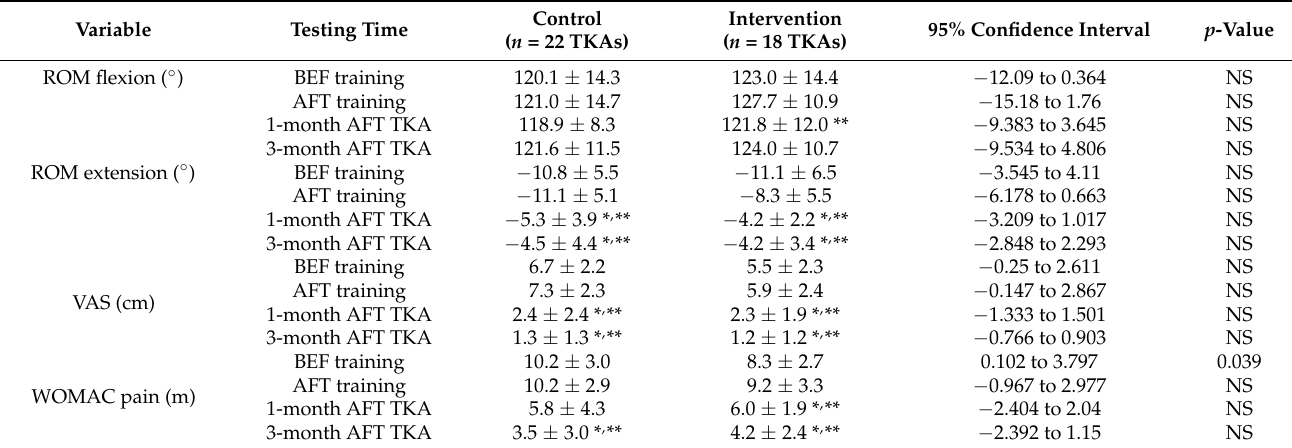
Figure 3. Comparison of quadriceps muscle strength between the intervention and control groups. Data are presented as mean ± standard deviation. *, p < 0.05, compared with BEF training; ‡, p < 0.05, compared with AFT training; ¶, p < 0.05, compared with 1M AFT TKA; #, p < 0.05, compared with the control group. BEF, baseline 3 weeks before surgery; AFT, after 3 weeks of preoperative training; M, month; TKA, total knee arthroplasty. Data are presented as mean ± standard deviation. The range of motion for knee extension significantly improved in both groups at 1 and 3 months after total knee arthroplasty compared to their performance at baseline and after 3 weeks of preoperative training. The range of motion for knee flexion significantly decreased in the intervention group 1 month after total knee arthroplasty compared to their performance after 3 weeks of preoperative training. The control group did not differ significantly at each time period. There were no significant differences in the range of mo ‐ tion for knee flexion or extension between the groups (Table 2). VAS score (operative side) significantly improved in both groups at 1 and 3 months after total knee arthroplasty com ‐ pared with that at baseline and after 3 weeks of preoperative training. There were no sig ‐ nificant differences between the groups at any time (Table 2). Table 2. Comparison of outcome measures between the intervention and control groups.